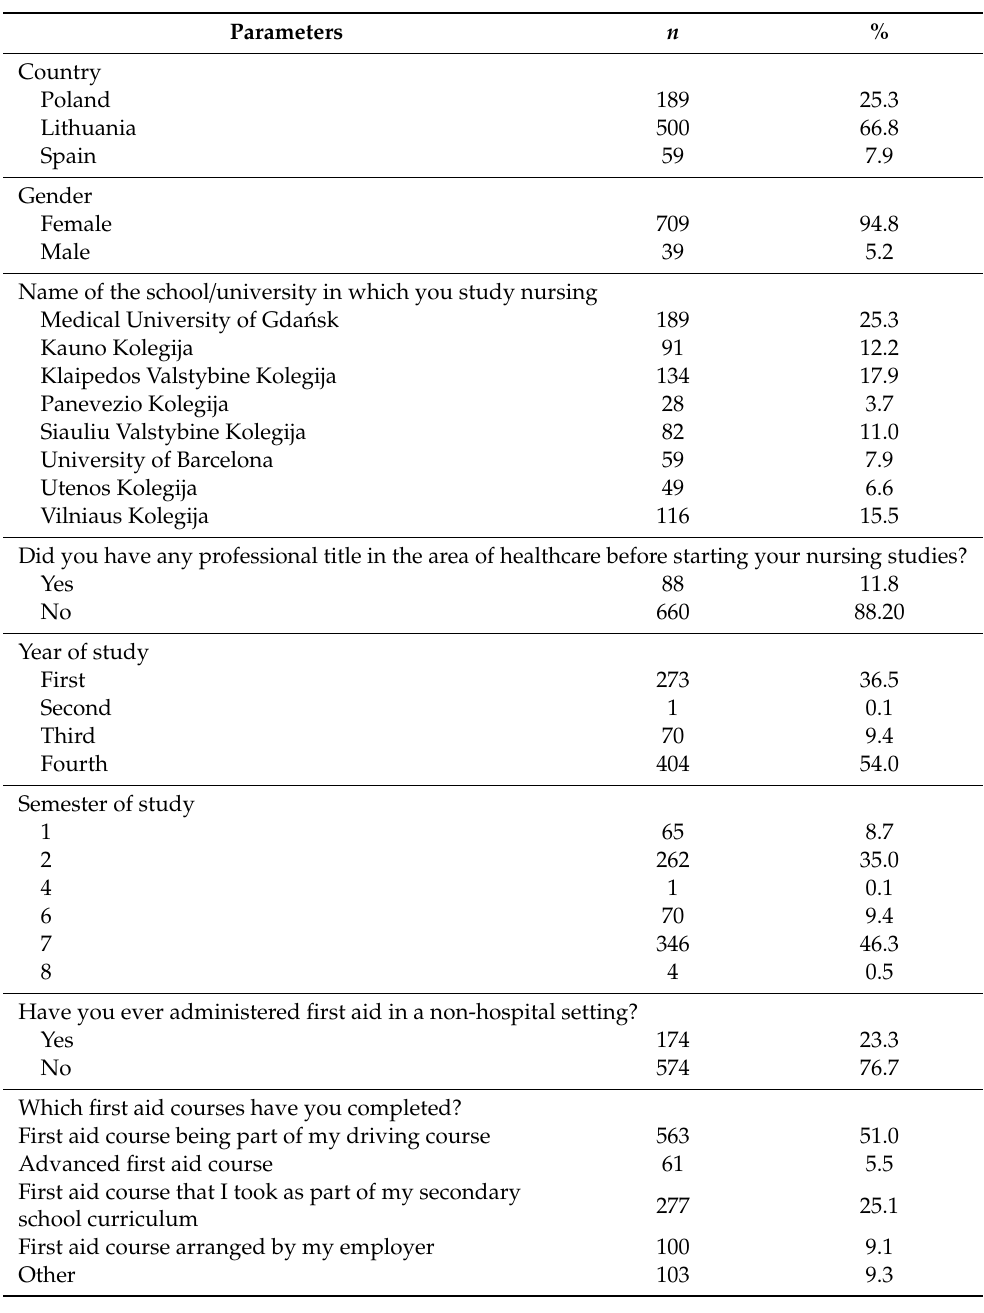
Table 1. Socio-demographic characteristic of the nursing